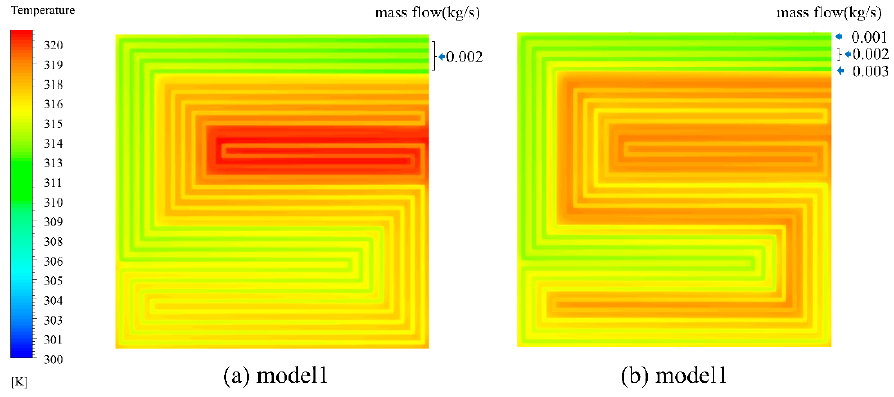
Figure 14. Effect of changing inlet flow on temperature distribution.